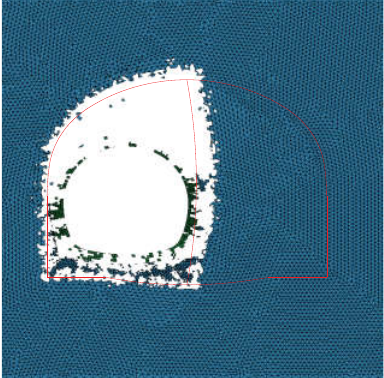
Figure 6. Expanded tunnel blasting effect caused by the CD excavation